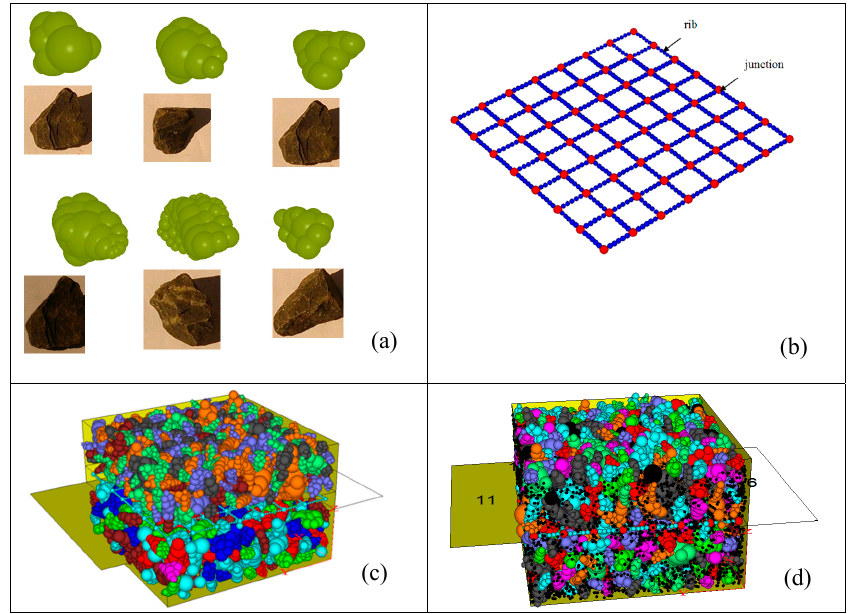
Figure 14. DEM model of geogrid-reinforced ballast: ( a ) simulated ballast aggregates; ( b ) geogrid; ( c ) fresh ballast; ( d ) fouled ballast (VCI = 40%) (modified after Ngo et al. [31]).